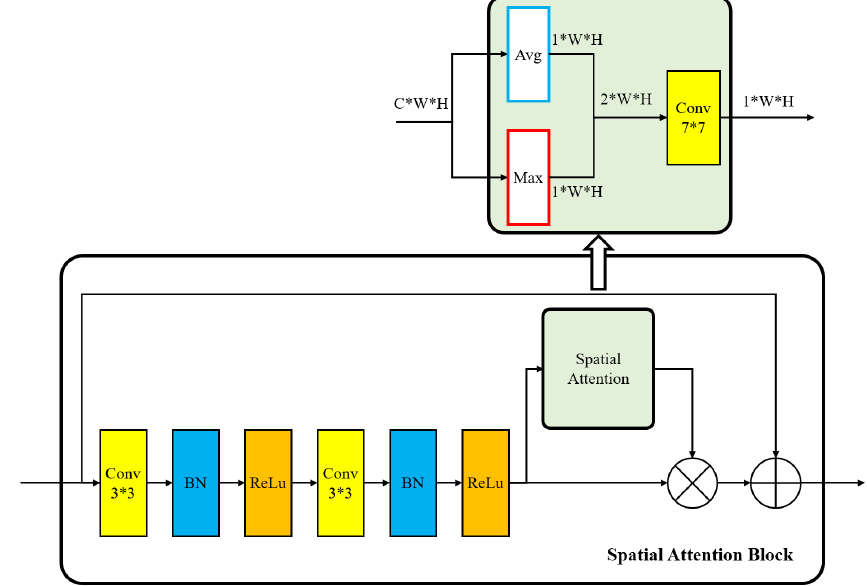
Figure 4. Spatial Attention Block. Conv: Convolutional Layer; BN: Batch Normalization Layer; ReLu: ReLU Activation Layer; Avg: Average by Channel; Max: Maximum by